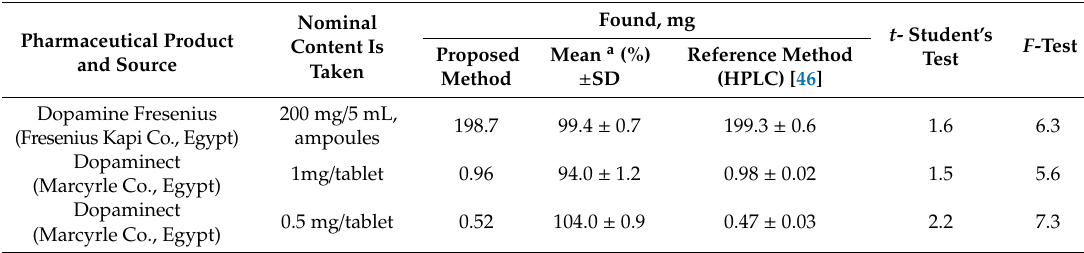
Table 2. Dopamine determination in pharmaceutical preparations using the proposed membrane sensor. Pharmaceutical Product and Source